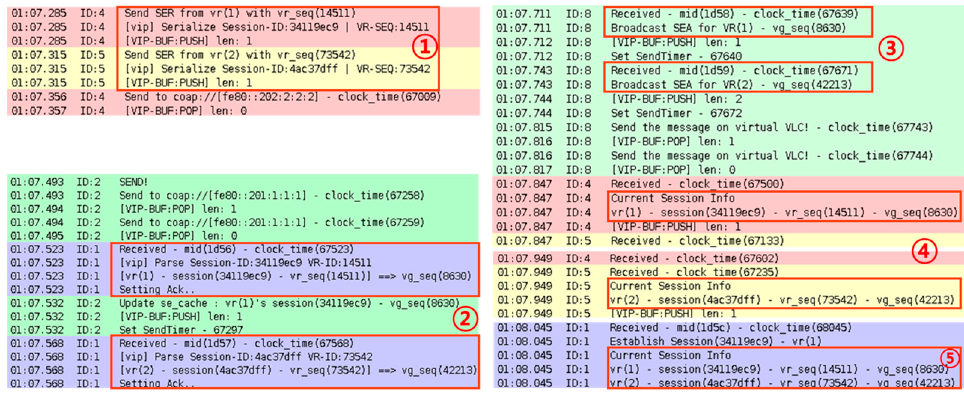
Figure 19. Packet analysis for session establishment.